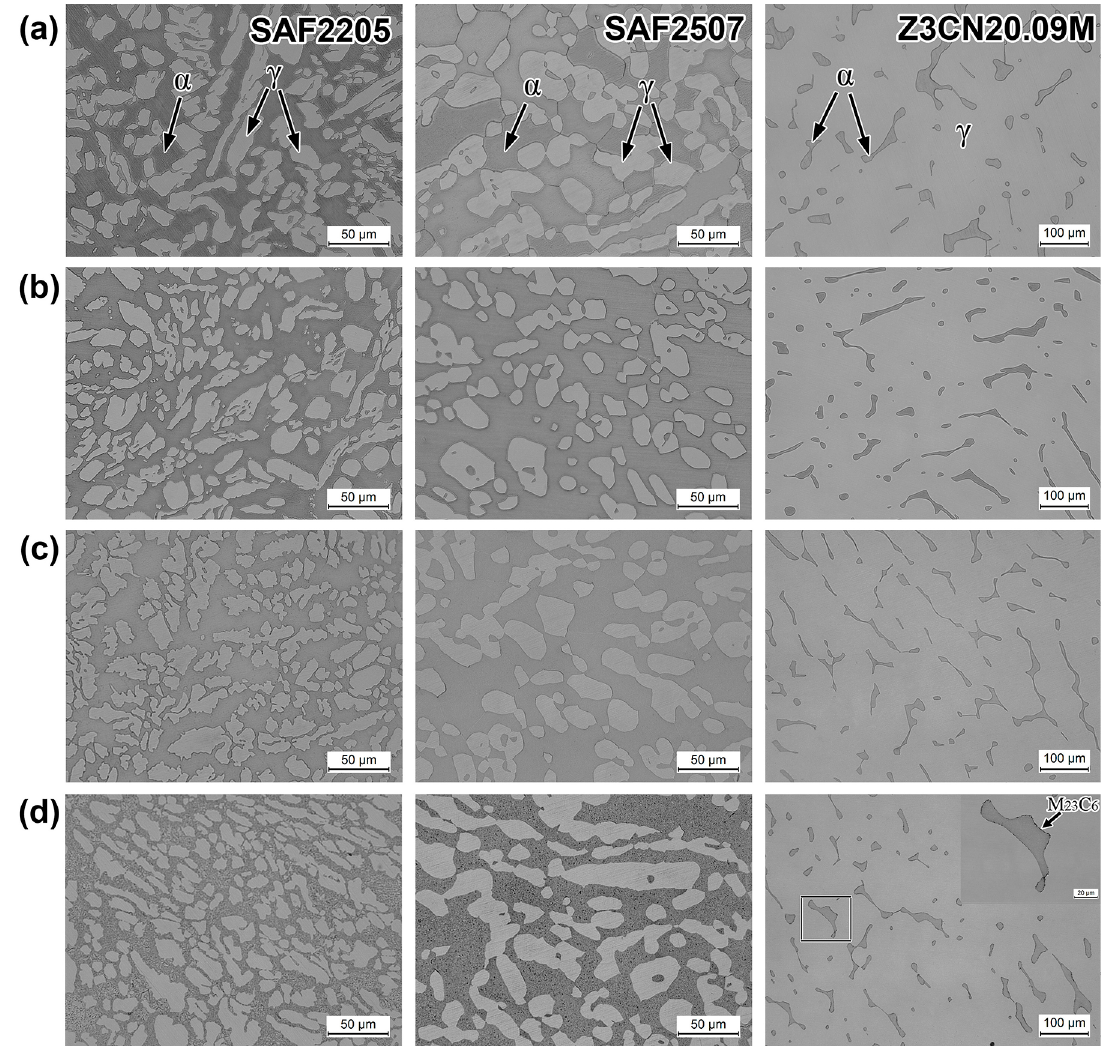
Figure 1. Microstructures of DSS specimens solid solution (a) and thermally aged for 5500h at different temperature (b) 350℃, (c) 450℃, (d) 500℃